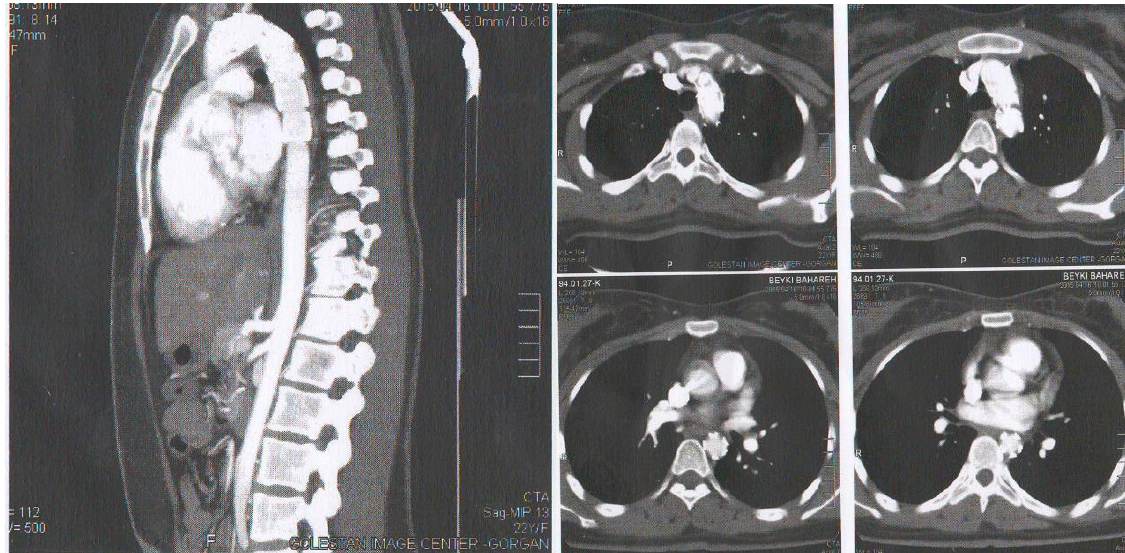
Figures 1A and B. Spiral thoracic and abdominal aortic computed tomography angiography with contrast; scan was performed with 16-slice MSCT. The stent is noted in the aortic arch and proximal descending aorta. No aneurysm or dissection is seen, and there is no significant